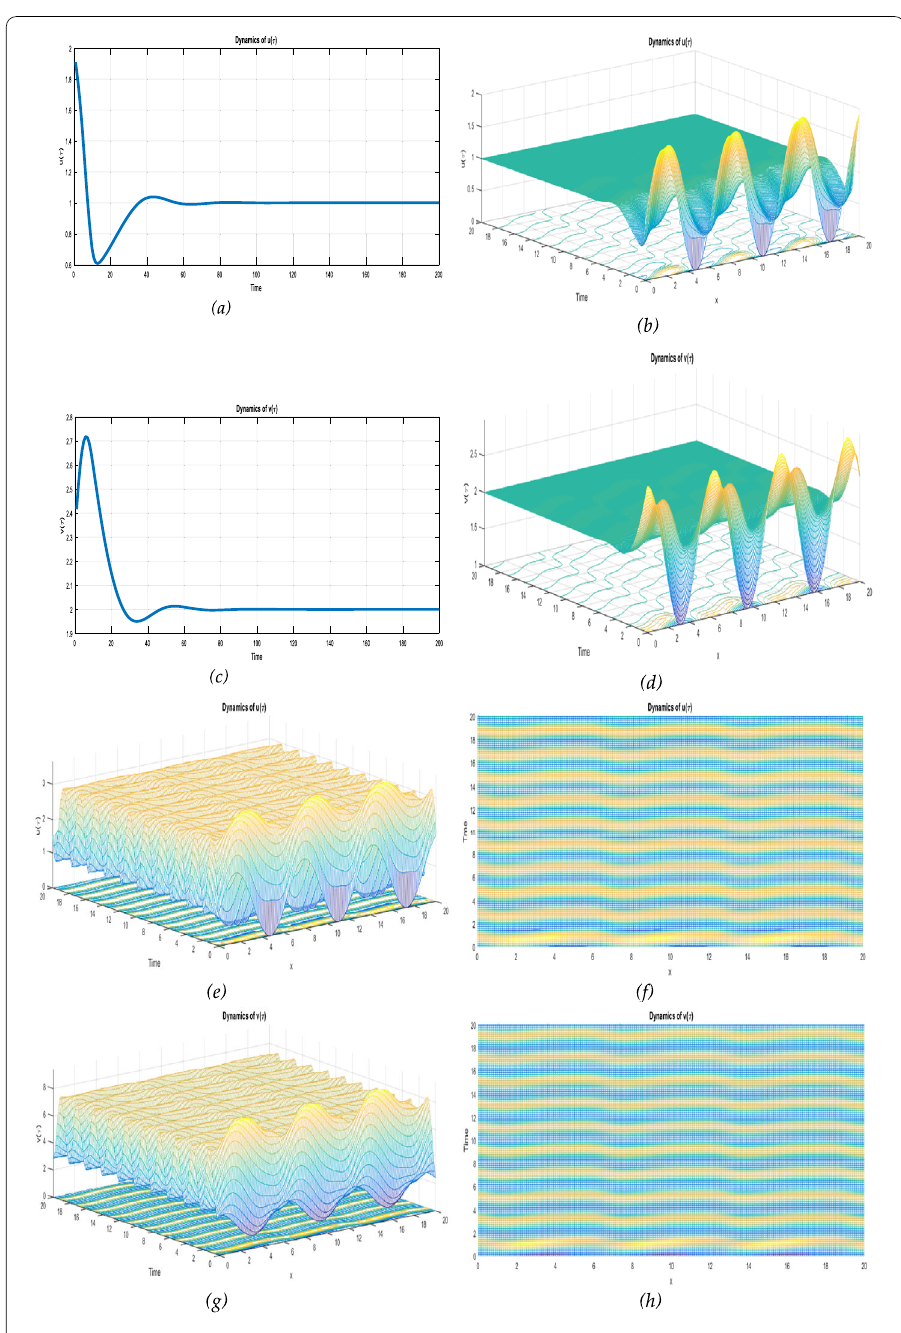
Figure 2 ( a )–( d ) Numerical solutions of system (32) using Crank–Nicolson scheme. Here, u 0 = 1 + sin( x ) and v 0 = 2 + cos( x ), with l = 5, m = 1, κ 1 = 0.01, and κ 2 = 0.01. (Top) The concentration of u ( τ ) is on the left while the concentration of v ( τ ) is on the right. (Bottom) The solutions v ( x , τ ) and u ( x , τ ) tend to the constant steady state. ( e )–( h ) Numerical solutions of system (32) using Crank–Nicolson scheme. Here, u 0 = 1 + sin( x ) and v 0 = 2 + cos( x ), with l = 10, m = 5, κ 1 = 0.01, and κ 2 = 0.01. (Top) The solutions v ( x , τ ) and u ( x , τ ) tend to the spatially homogeneous periodic orbit. (Bottom) The projected views onto the x τ -plane at τ = 20 for v ( x , τ ) and u ( x , τ ). The stripe structure invades the homogeneous periodic orbit for u ( x , τ ) and v ( x , τ